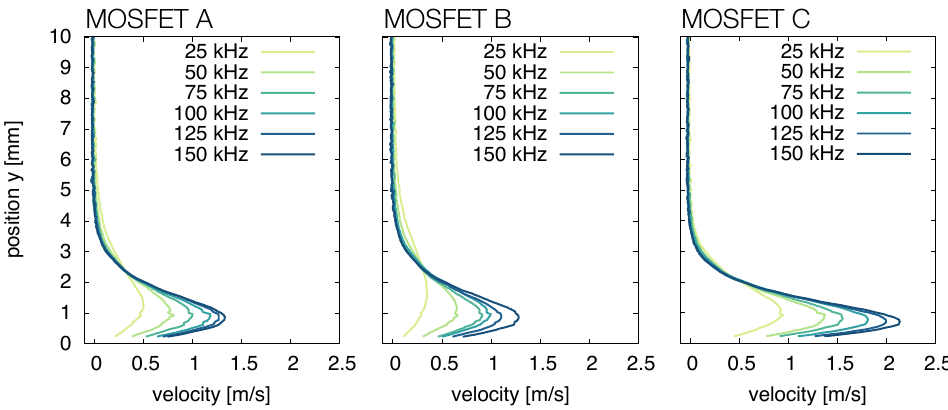
Figure 6. Velocity profiles at x = 30 mm for different